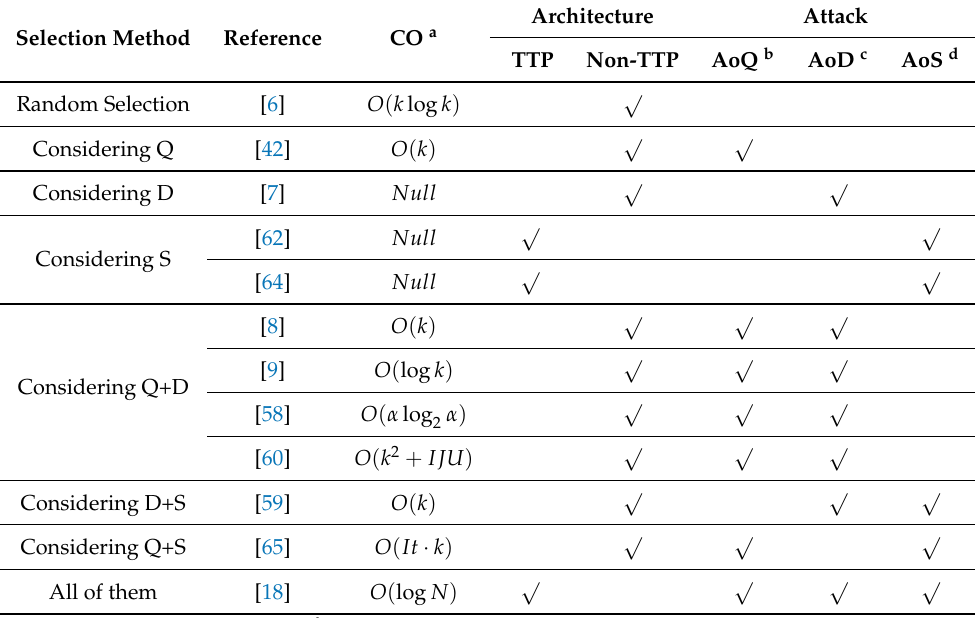
Table 4. Summary of dummy